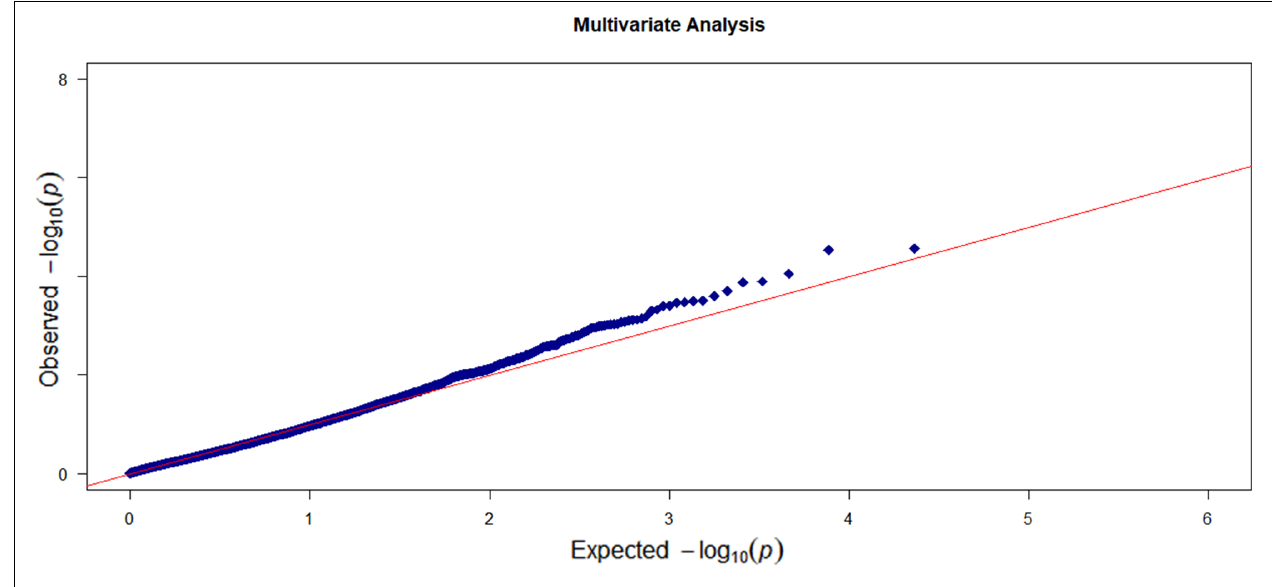
FIGURE 3 | The Q – Q plot of the observed –log10 ( p -value) versus the expected –log10 ( p -value) for the six enzyme traits based on the multi-trait analysis.